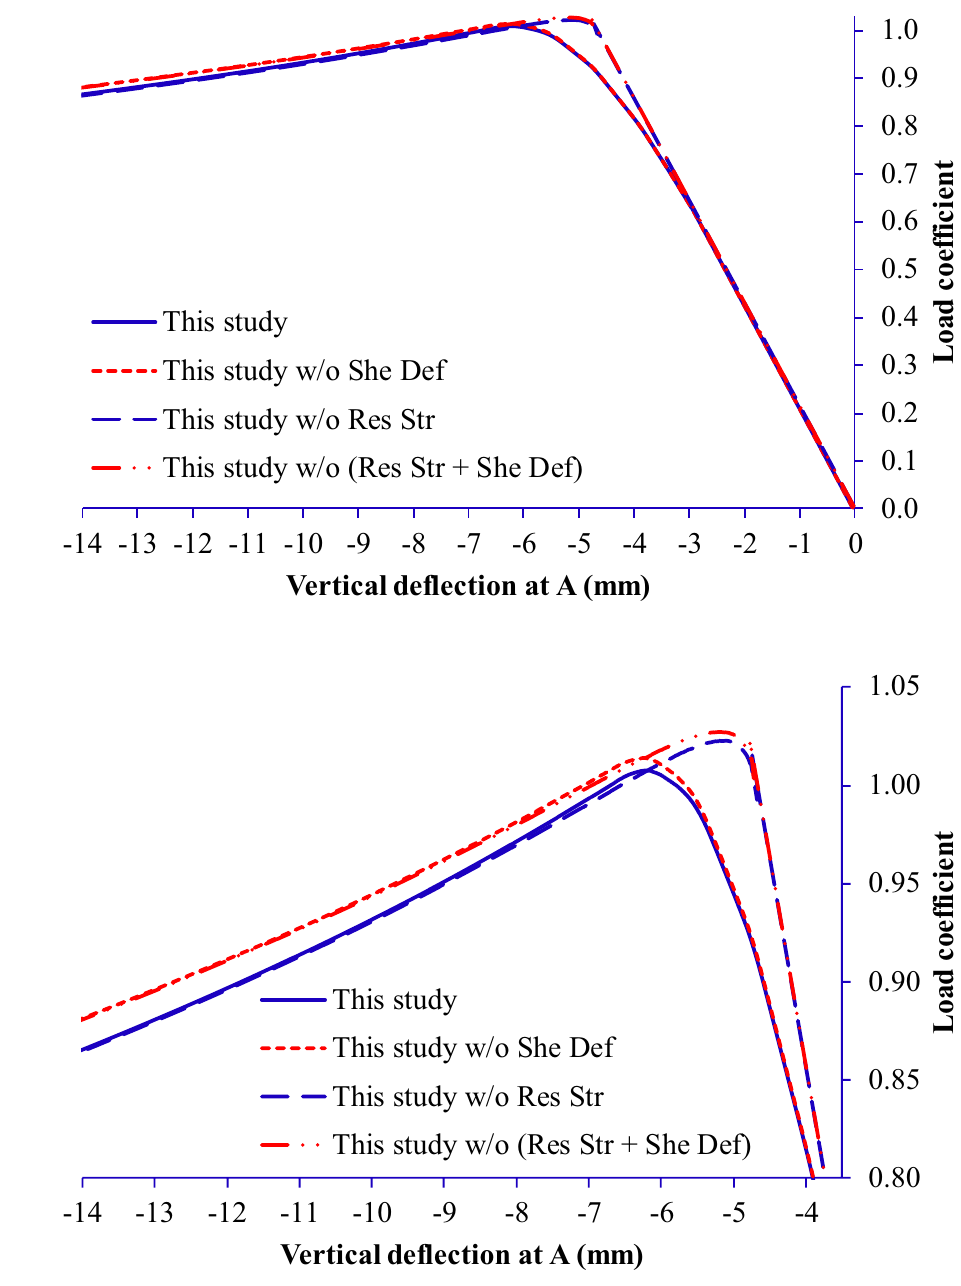
stresses do not affect global structural stiffness in the beginning, but shear deformation has significant influ- ences during the incremental iterative solution proce- dure. Residual stresses definitely affect the behavior and strength of this frame at the load coefficient of 0.6 because, from this time, some fibers start yielding. From Fig. 6 and Table 1, horizontal deflection at node A of the frame in case 3 and 4 without considering residual